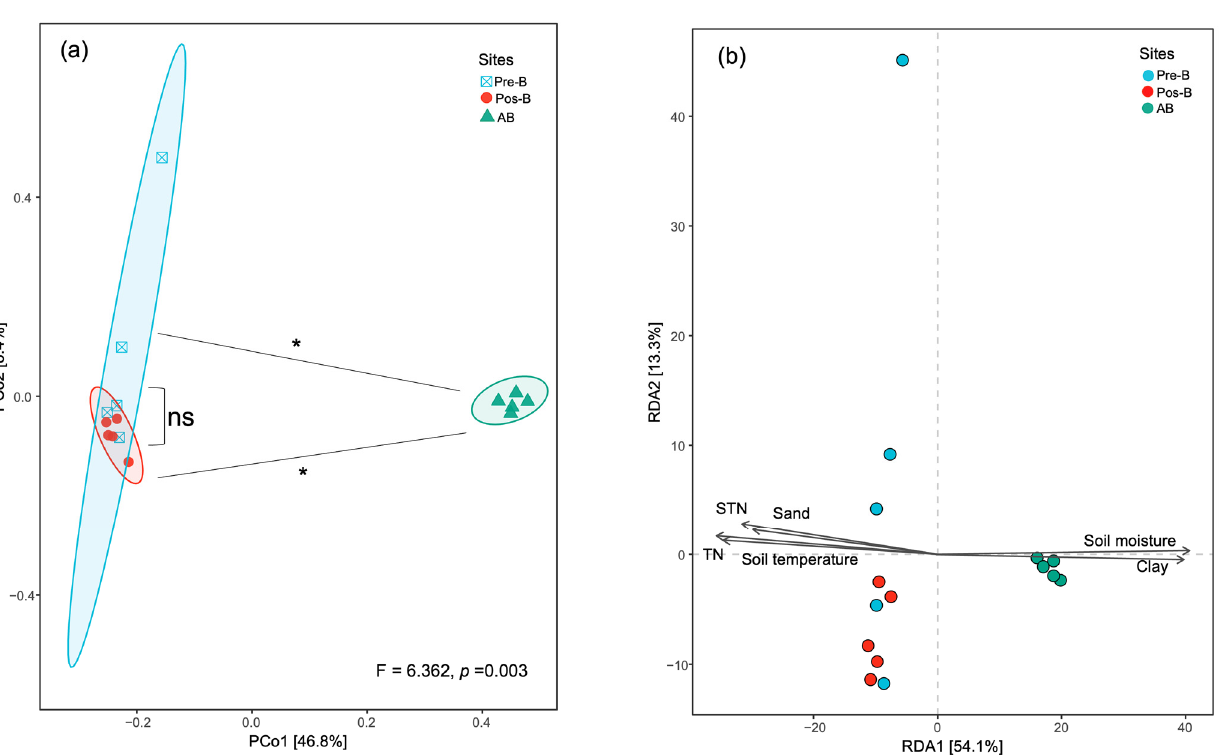
Figure 6. Bacterial community composition and correlations to soil properties. ( a ) Principal coordinate Figure 6 . Bacterial community composition and correlations to soil properties . ( a ) Principal analysis (PCoA) ordination based on the Bray–Curtis distance, showing the community composition coordinate analysis ( PCoA ) ordination based on the Bray – Curtis distance, showing the community of bacteria detected in the study sites. ( b ) RDA ordination presents soil properties that significantly composition of bacteria detected in the study sites . ( b ) RDA ordination presents soil properties that correlated with community composition. Significant parameters indicated with the Mantel significantly correlated with community composition . Significant parameters indicated with the Mantel test . Pre - B — preburning; Pos - B — postburning; AB — 1 year after burning . * indicates statistically difference.